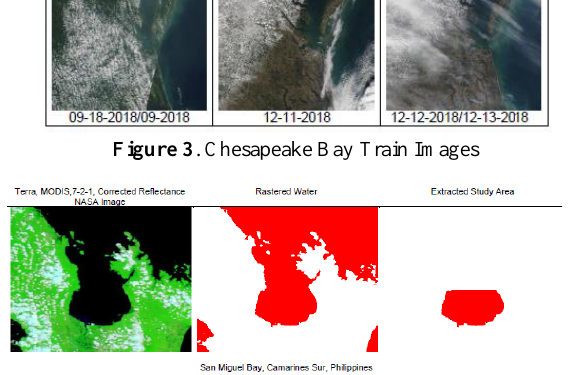
Figure 5. From the coordinates generated in the second